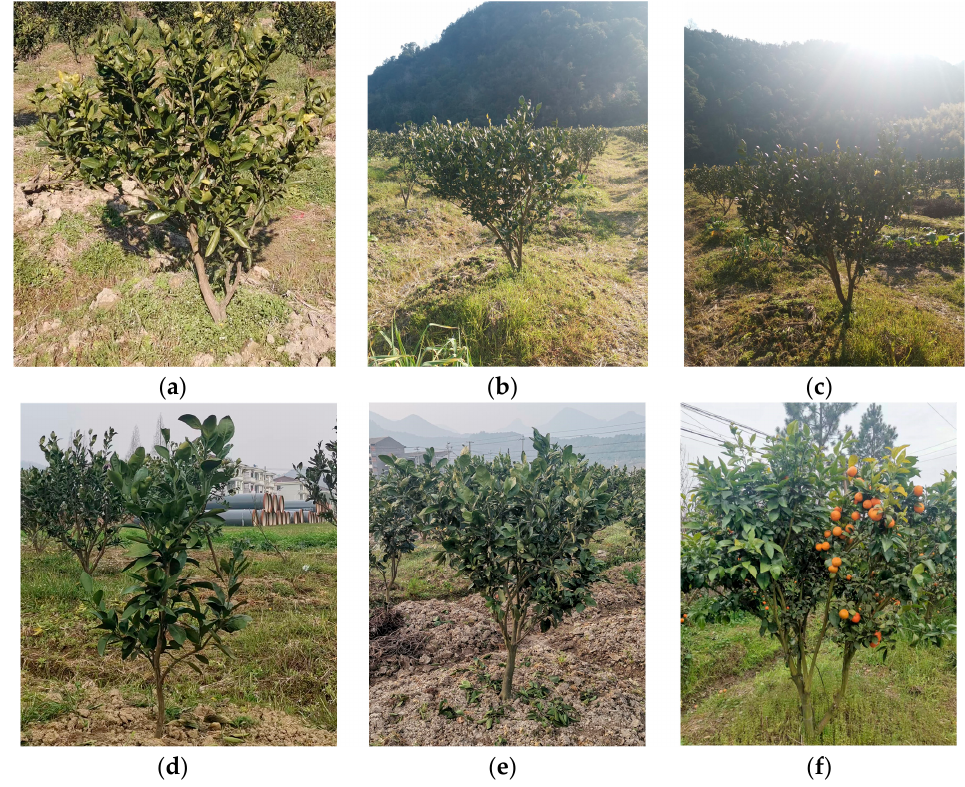
Figure 2. Example citrus tree images: ( a ) forward light, ( b ) slight backlight, ( c ) severe backlight, ( d ) seedling stage, ( e ) flourishing stage, ( f ) fruiting stage.